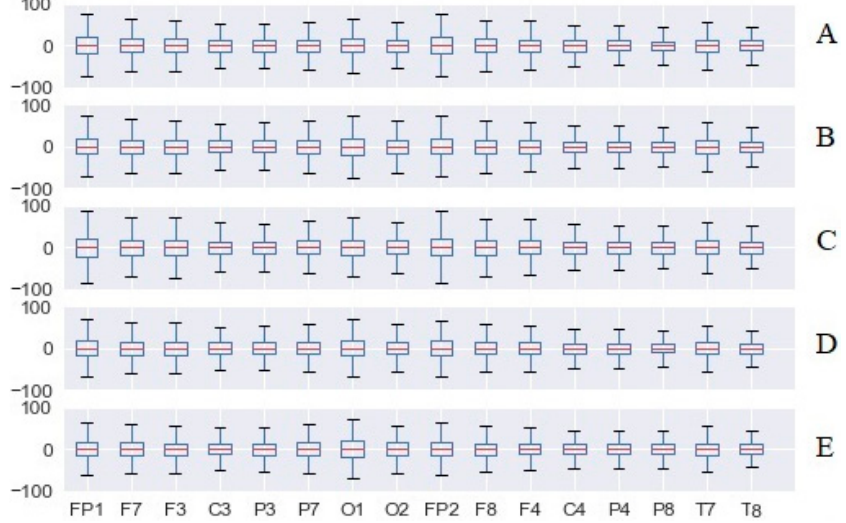
Figure 15. The total cognitive load of all electrodes for white cane navigation.